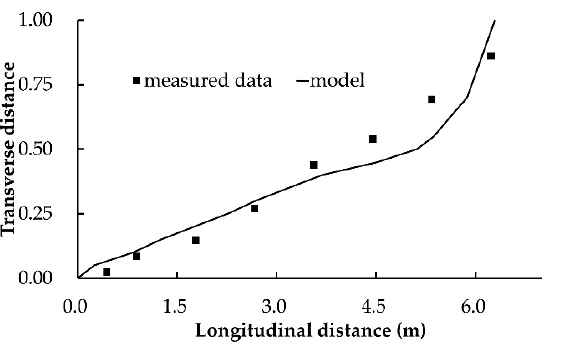
Figure 7. Larger velocity core shifting process. The bend length along the flume centerline is about 5.73 m. The transverse distance is from the bend inner bank, normalized by width.